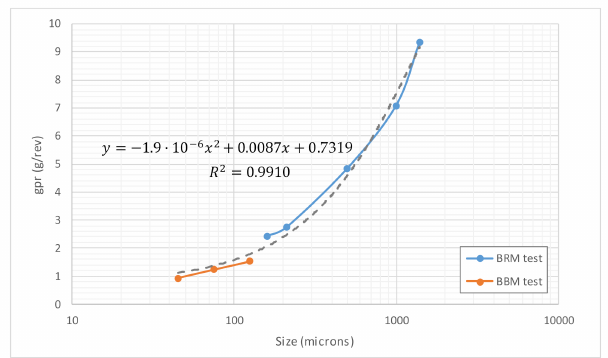
Figure 9. Variation of BBM and BRM gpr values with P 100 , Panasqueira ore.